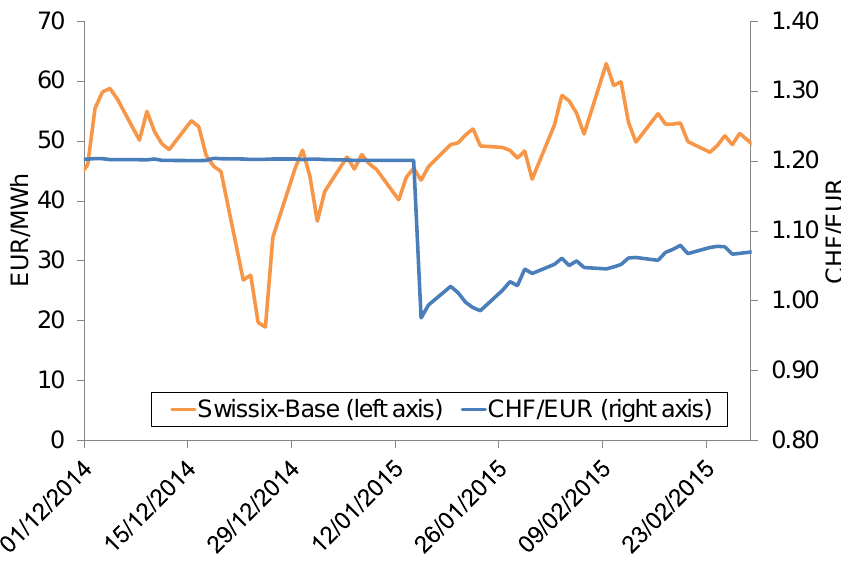
Figure 2. The evolution of Swissix baseload electricity prices and exchange rate (CHF per EUR) around 15 January